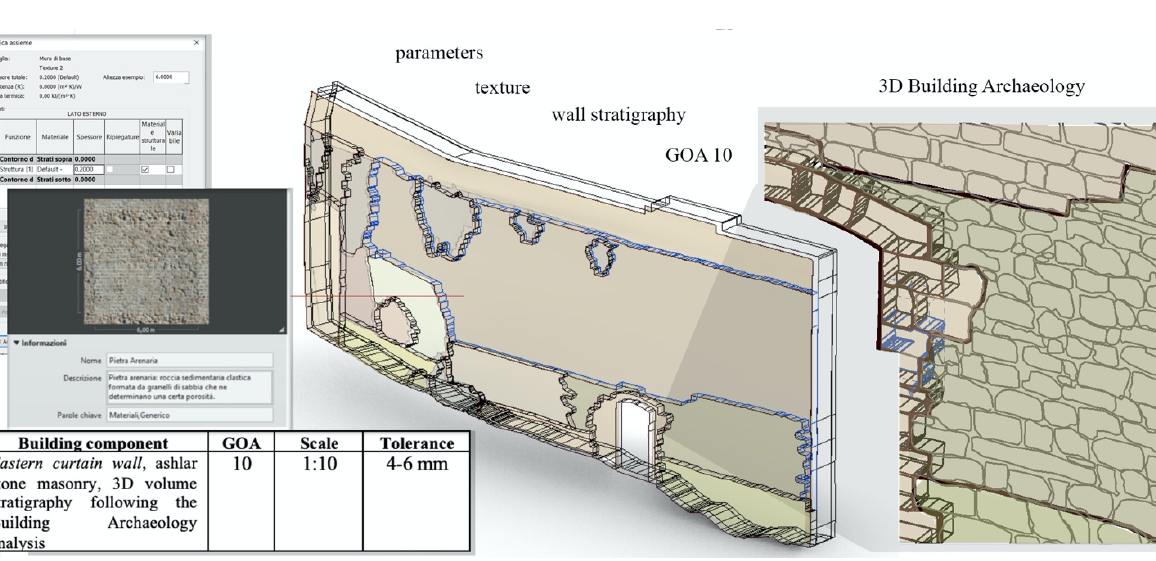
the polygonal bastion are instead the most remodelled over time.